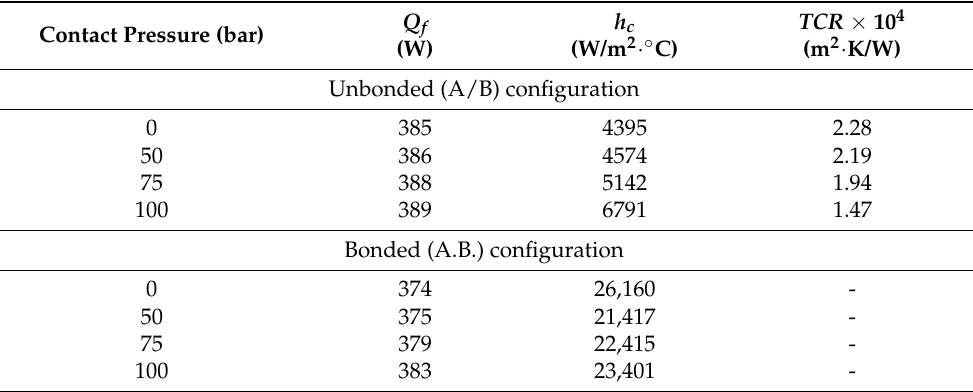
Table 1. Thermal tests conditions and results for the unbonded (A/B) and bonded (A.B.) configura- tions with contact pressures of 0, 50, 75, and 100 bar.